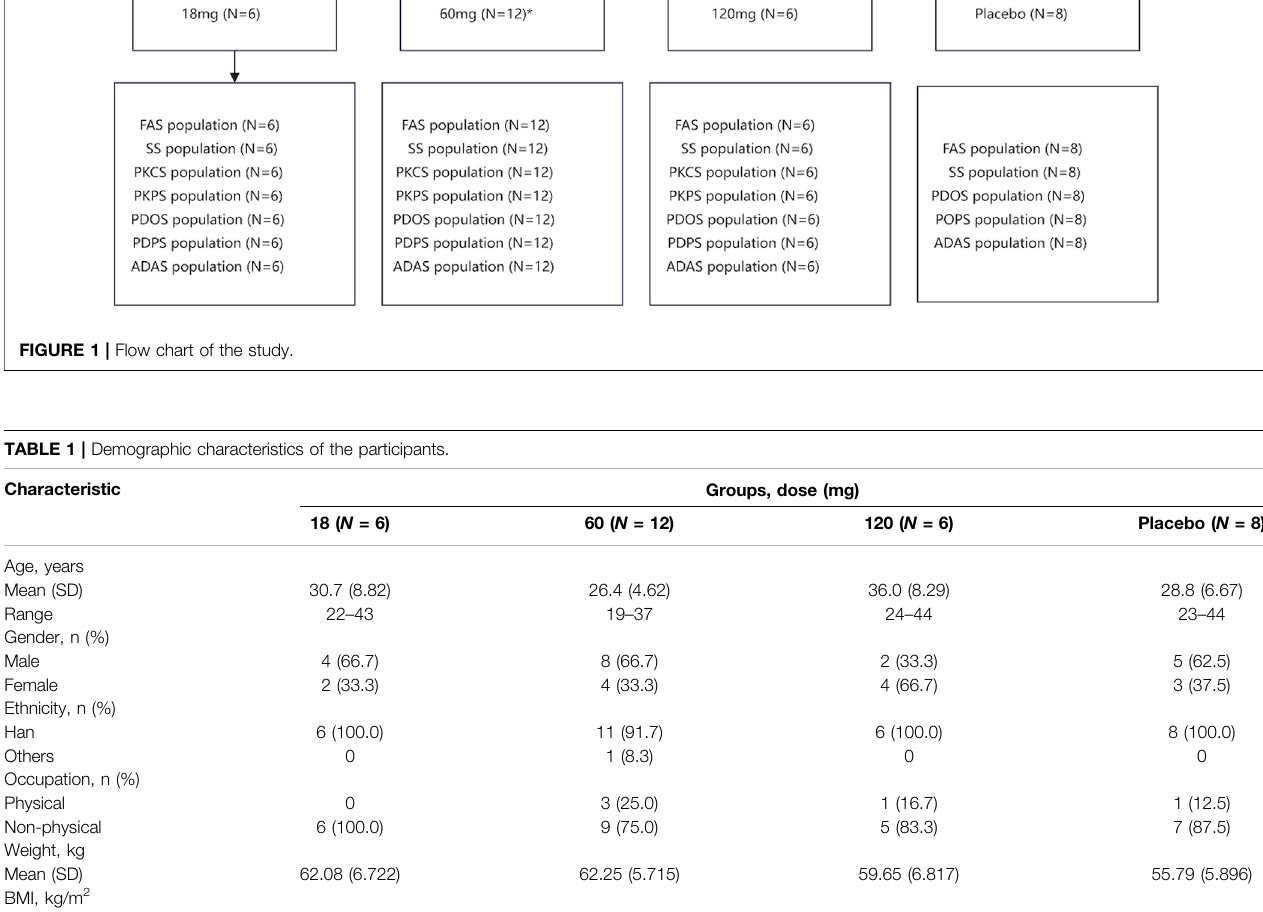
The serum concentration-time pro fi le of LY06006 is displayed in Figure 2 . LY06006 was rapidly absorbed with detectable concentrations observed 6 h after the dose in all groups. The T max was relatively long, with a range of 120 – 480 h for all dose groups and serum LY06006 concentrations decreased slowly 11 – 13 days after dosing with a long half-life ranging from 168 to 216 h.